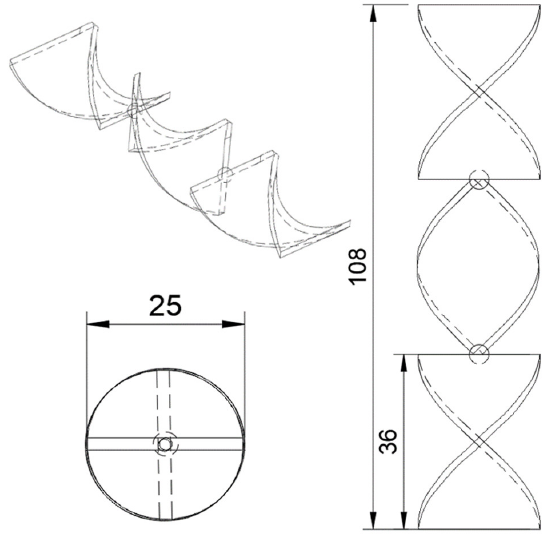
Figure 1. Static mixer dimensions in millimeters .